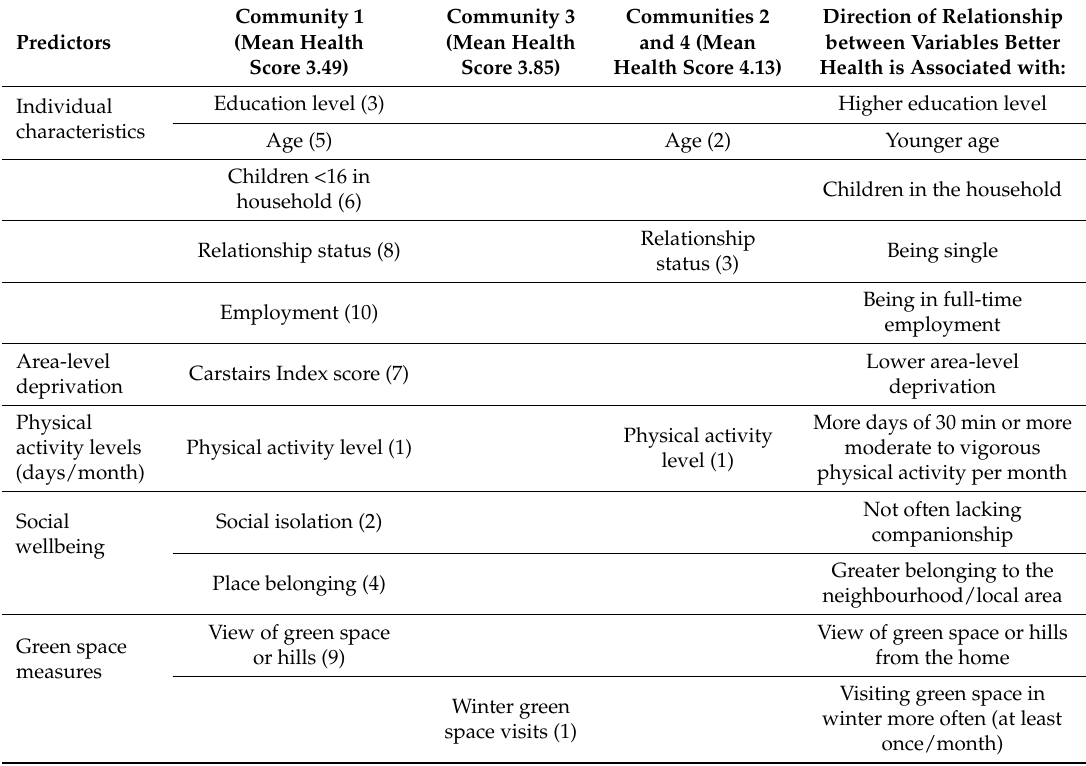
Table 3. Predictors of self-reported general health by Community, based on CCR Logistic regression models and chi-squared tests of